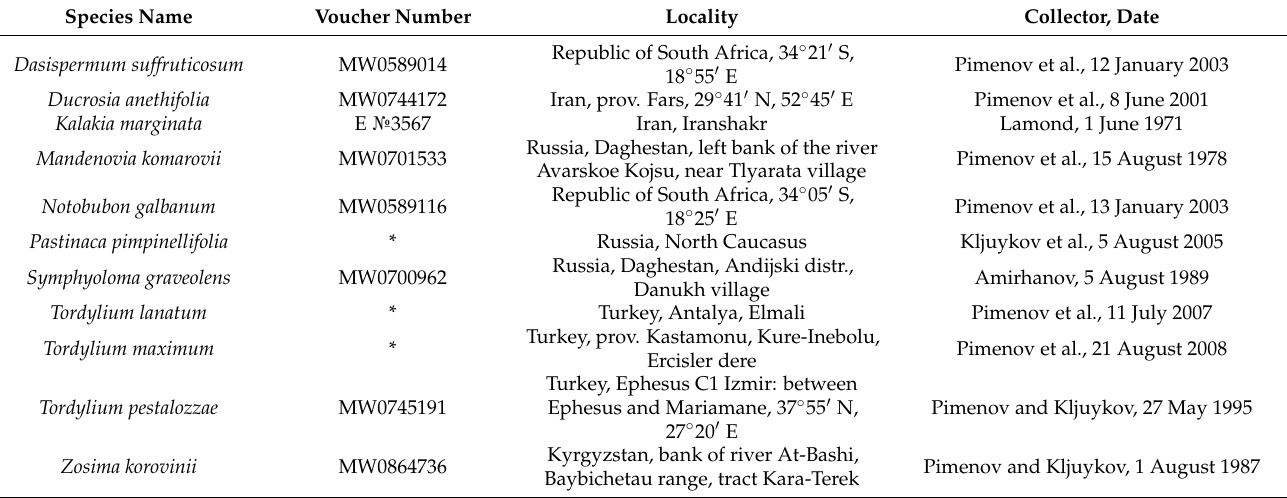
Table 3. Voucher information for studied species, including collector name and date. Samples from the carpological collection of the Botanical Garden of Moscow State University are indicated with an asterisk